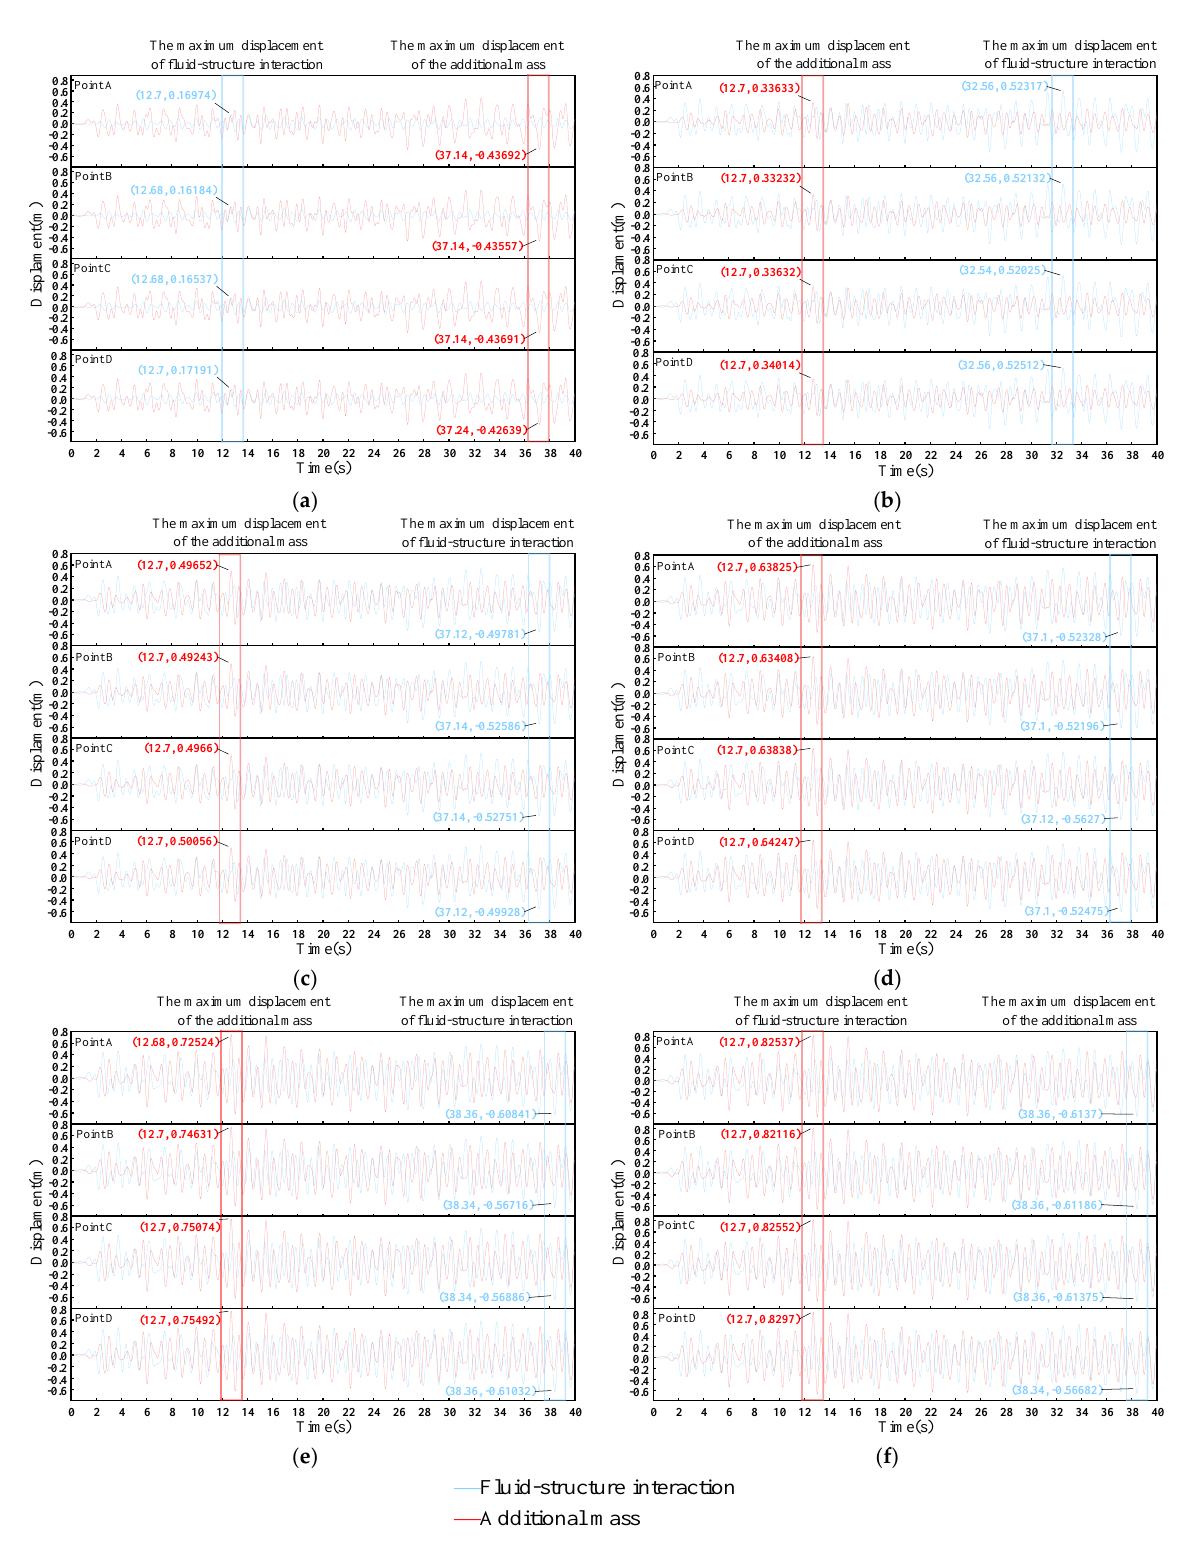
Figure 13. Seismic displacement response ( a ) Pipeline cross-section 1 displacement response time history curve; ( b ) pipeline cross-section 2 displacement response time history curve; ( c ) pipeline cross-section 3 displacement response time history curve; ( d ) pipeline cross-section 4 displacement response time history curve; ( e ) pipeline cross-section 5 displacement response time history curve; ( f ) pipeline cross-section 6 displacement response time history